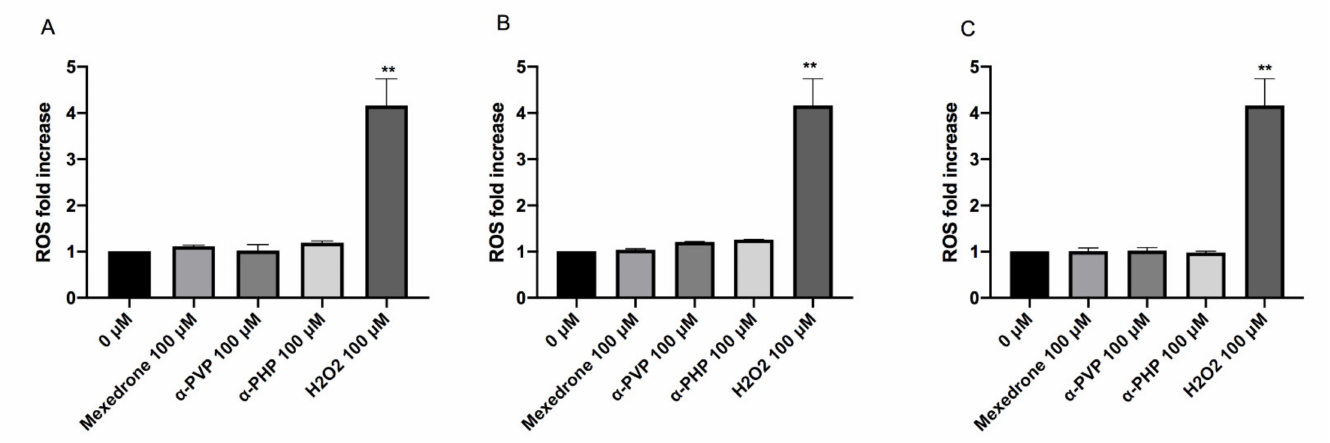
Figure 9. ROS fold increase on TK6 cells after 1 ( A ), 6 ( B ) and 12 ( C ) h treatment with mexedrone, α -PVP, α -PHP at the indicated concentrations compared to the negative control [0 µ M] and to positive control (H 2 O 2 ). Each bar represents the mean ± SEM of five independent experiments. Data were analyzed using repeated ANOVA followed by Bonferroni post-test. ** p < 0.01 vs. 0 µ